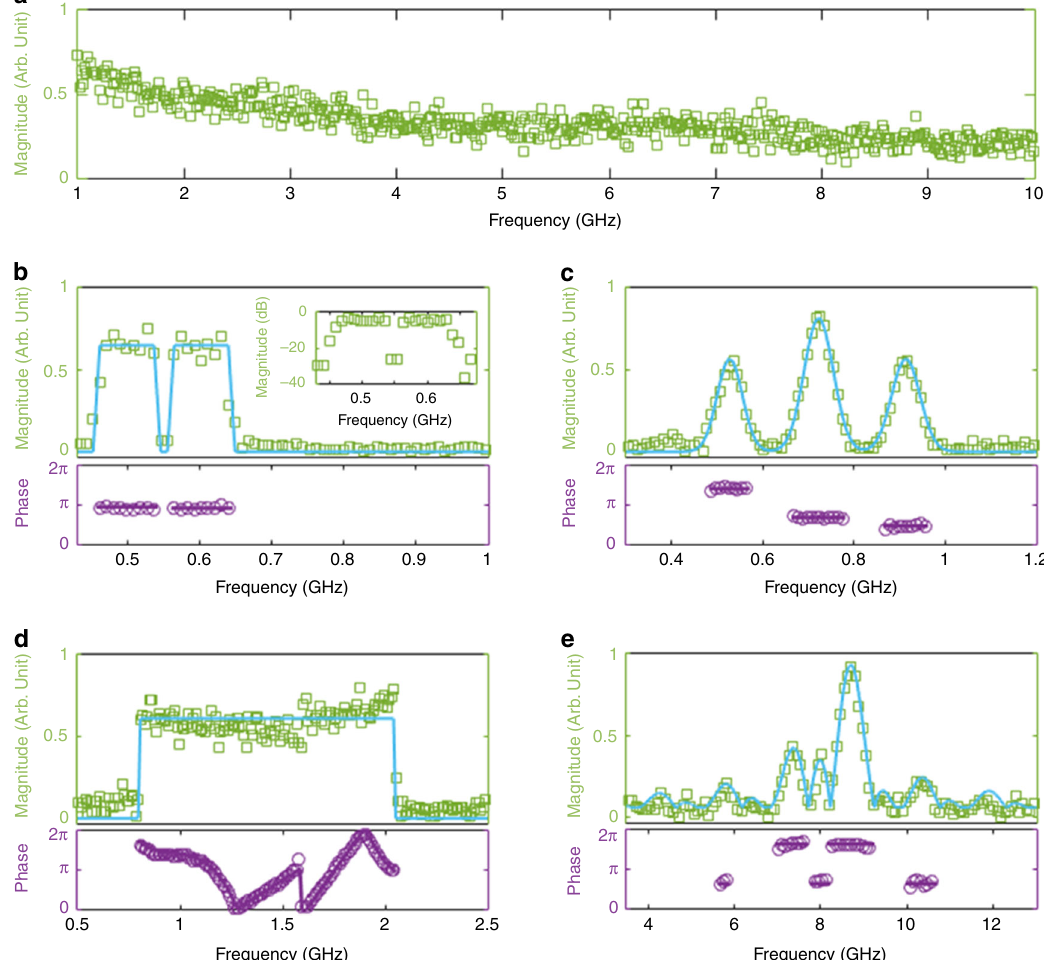
Fig. 3 Optical spectra with arbitrary magnitude and phase pro fi les. Experimental data are represented by symbols to show the spectral resolution of the OAWG (green squares: amplitude, purple circles: phase); the light blue (purple) solid line is the amplitude (phase) signal applied to the modulator and mapped into the spectral domain using the theoretical time-to-frequency scaling law (Eq. (3)). The frequency represented along the horizontal axis is the optical frequency relative to the frequency of the seed laser ( f 0 ). a optical spectrum generated at the output of the FSLs seeded by an un-modulated CW laser. About 1000 spectral components separated by f s = 9.482 MHz are generated. b fl at-top amplitude with suppressed central frequency (20 MHz spectral bandwidth, 20 dB rejection), and constant phase. c combination of three Gaussian amplitudes with distinct uniform phases. d fl at-top amplitude and composite spectral phase, including cubic and linear pro fi les. a , b , c , d have been obtained with f s = 9.482 MHz. e example of broadband arbitrary complex- fi eld optical spectrum synthesis (with f s = 84.91 MHz). For plots b , c , d , e , the values of the RMS error between the generated (green) and the designed waveforms (light blue) are, respectively, equal to 0.10, 0.033, 0.080, 0.034 (in arb. units) for the magnitude, and 0.084, 0.090, 0.18, and 0.18 (in radians) for the phase. These values were calculated over the whole displayed frequency range, except in b , where they were calculated between 0.43 GHz and 0.7